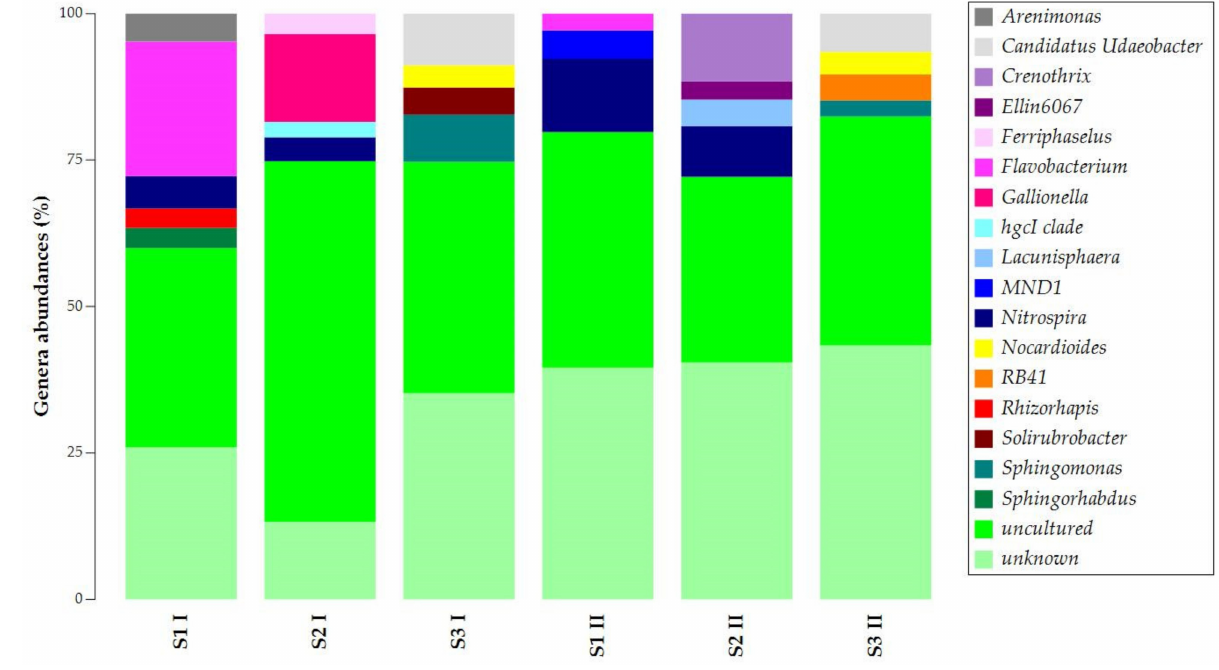
Figure 4. Taxonomy bar plot of ASVs at the genus level.